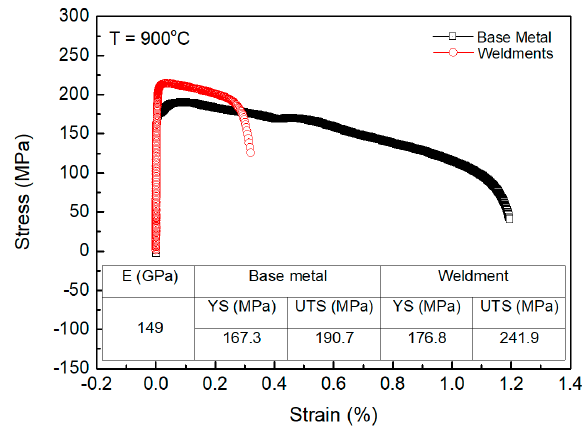
Figure 4. Tensile curves of Alloy 617 base metal and weldment at 900 °C.